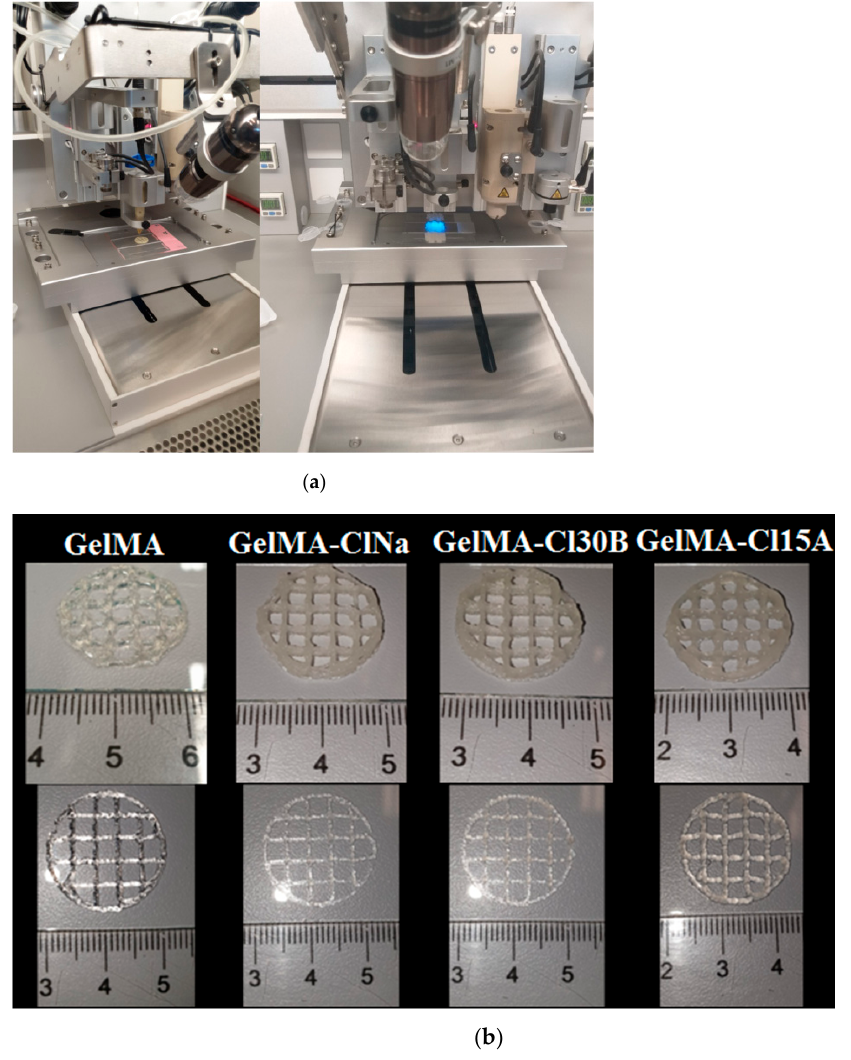
Figure 11. ( a ) 3D printing process. ( b ) The appearance of the 3D printed constructs based on nano- composite hydrogel inks GelMA, GelMA-ClNa, GelMA-Cl30B, GelMA-Cl15A (5 layers and 1